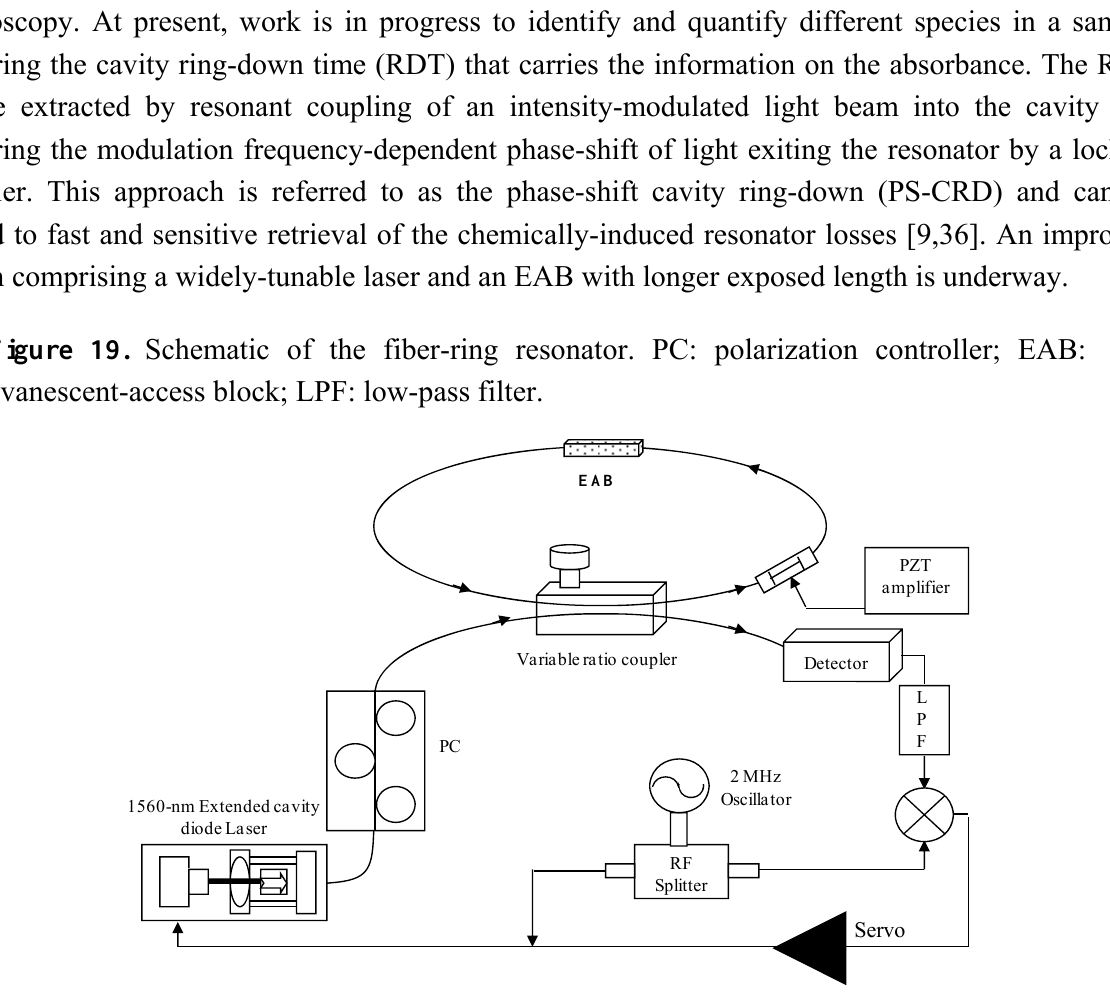
Figure 20. Locking of the laser to the fiber cavity resonance. Top: cavity transmitted power for free-running (black solid line) and locked laser with different low and high servo gains (gray and dotted line, respectively). Bottom: PDH error signal in unlocked (black solid line) and locked cases (gray and dotted line,